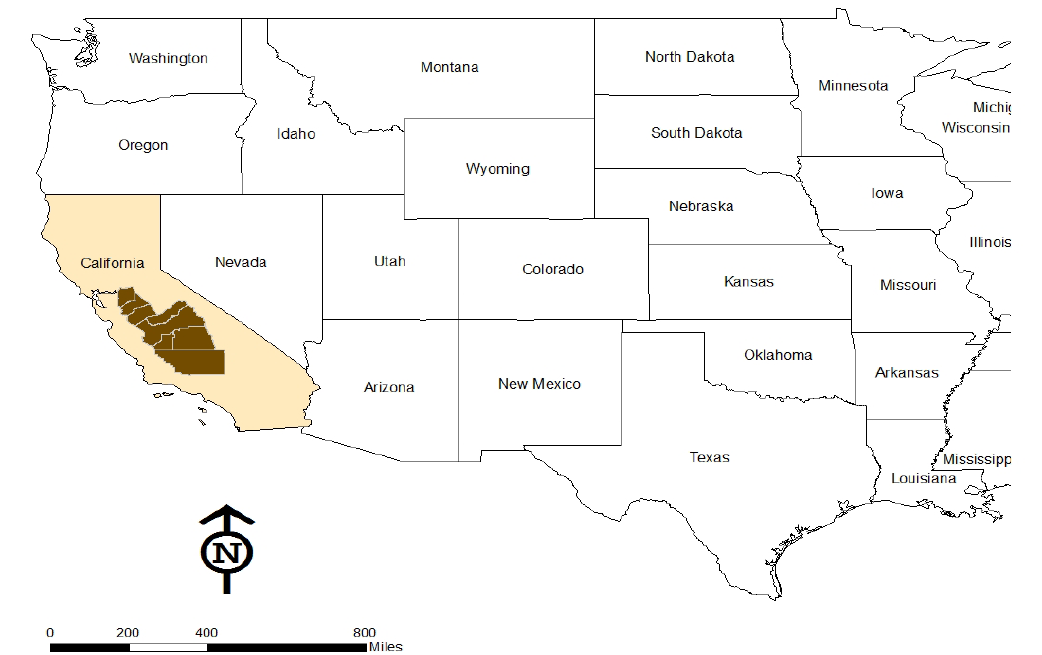
Figure 1. Study area: San Joaquin Valley